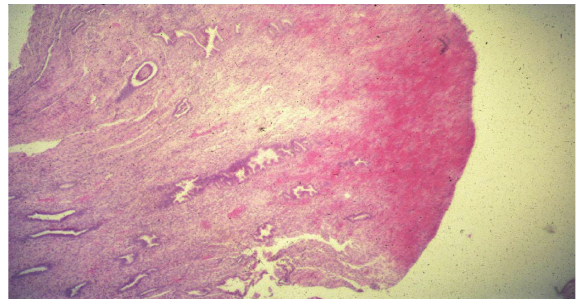
Figure 2: Light microscopy. Hematoxylin and eosin stain of cross- section of a large cornual polyp. Note secretory changes within endometrial glands. Infarction is evident at the right extremity of the polyp. Magnification ×